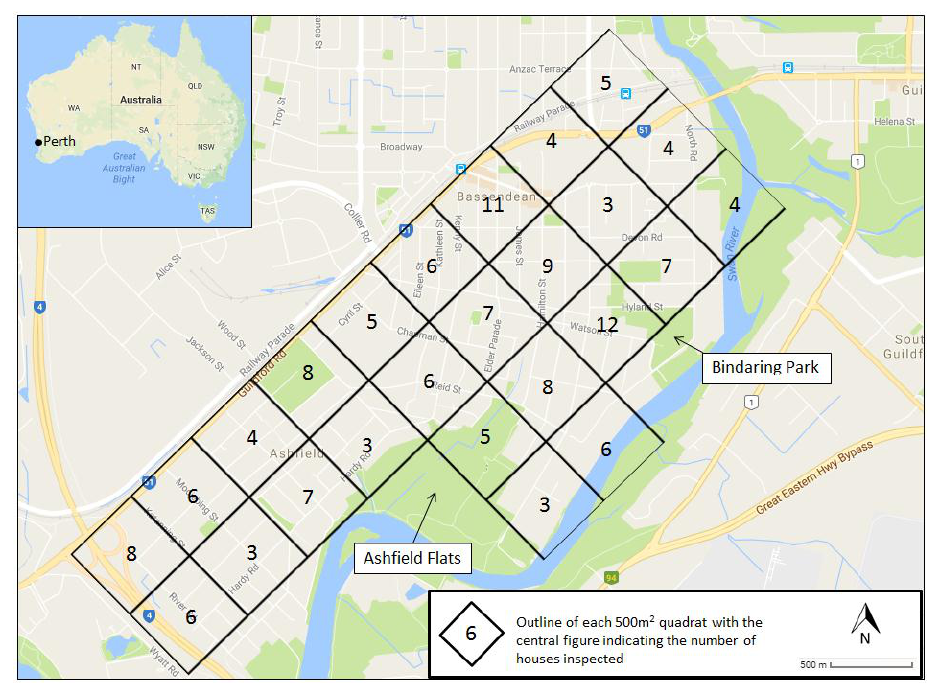
Figure 1. The study area of the Town of Bassendean, Perth Western Australia divided into 25 quadrants. Numbers indicate the randomly generated number of households to be interviewed within each quadrat to obtain KAP (knowledge, attitudes, and practices) data for this